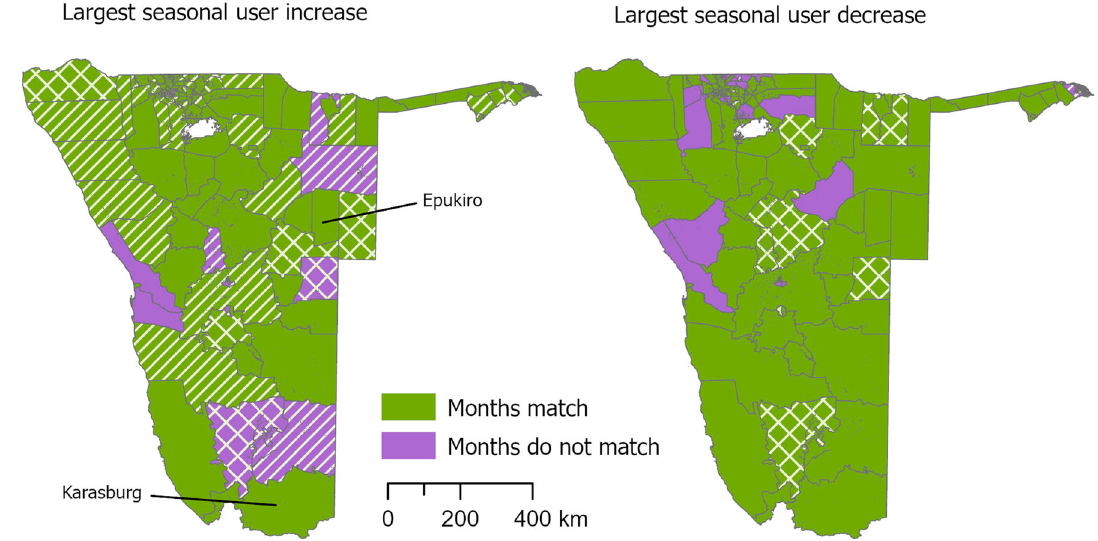
Fig. 5 Comparison between results from the Tower Range and Adjusted Voronois methods via the month with the largest user change at level 2. No hatch = both methods have similar values (±3%); simple hatch: Adjusted Voronois > Tower Ranges + 3%; cross hatch: Tower Ranges > Adjusted Voronois +